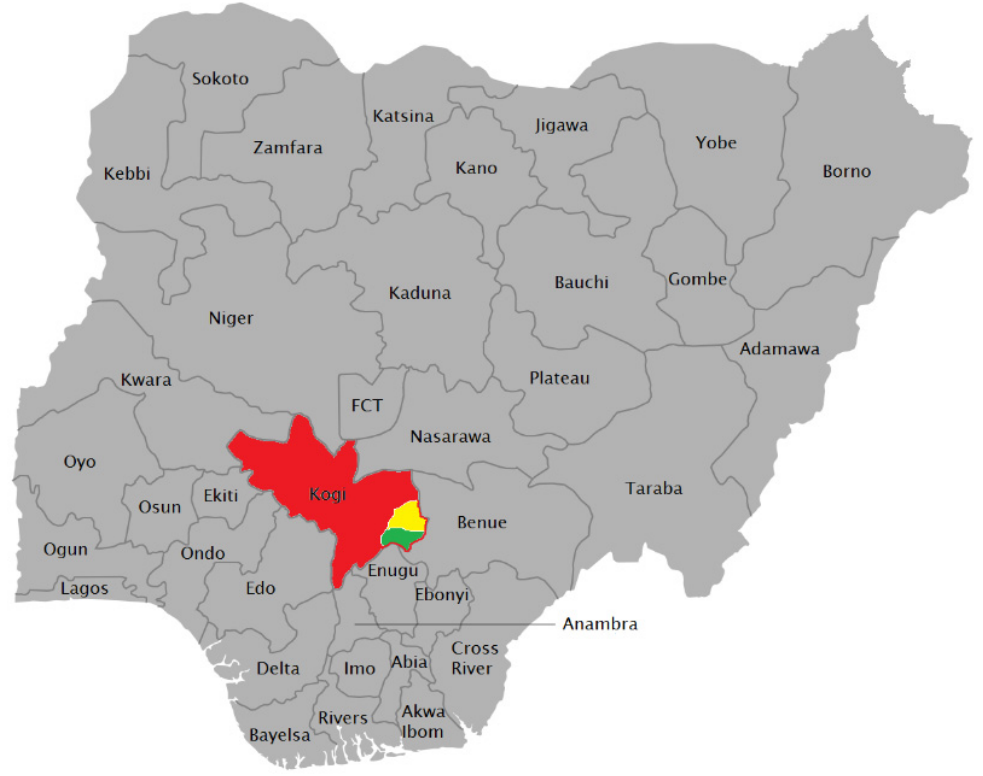
Figure 1. Map of Nigerian states showing the location of Ankpa LGA (yellow) and Olamaboro LGA (green), both in Kogi state (red). Modified from [15].